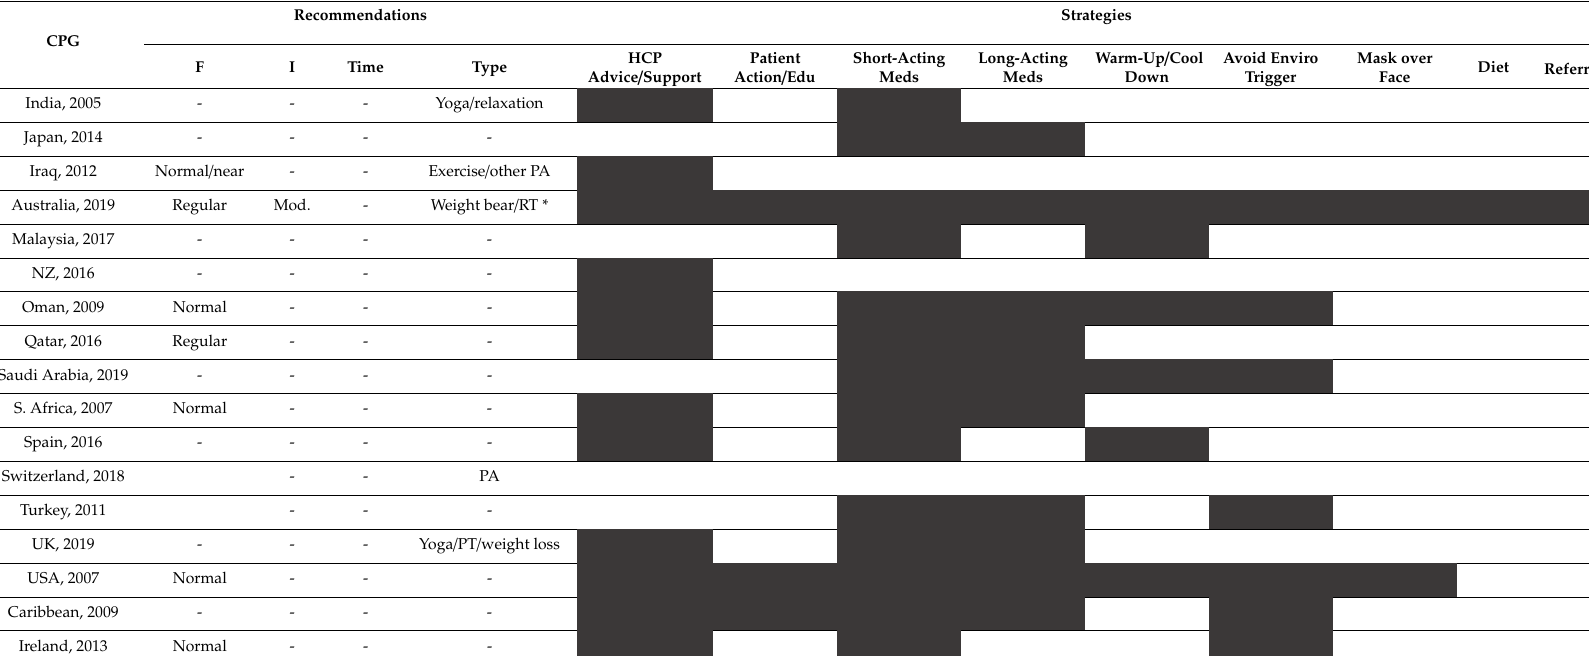
Table 1. Physical Activity Recommendations and Strategies from Clinical Practice Guidelines on